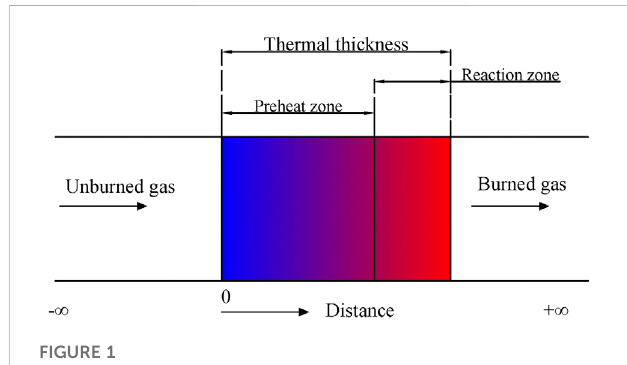
FIGURE 1 Schematic illustration of a laminar premixed fl